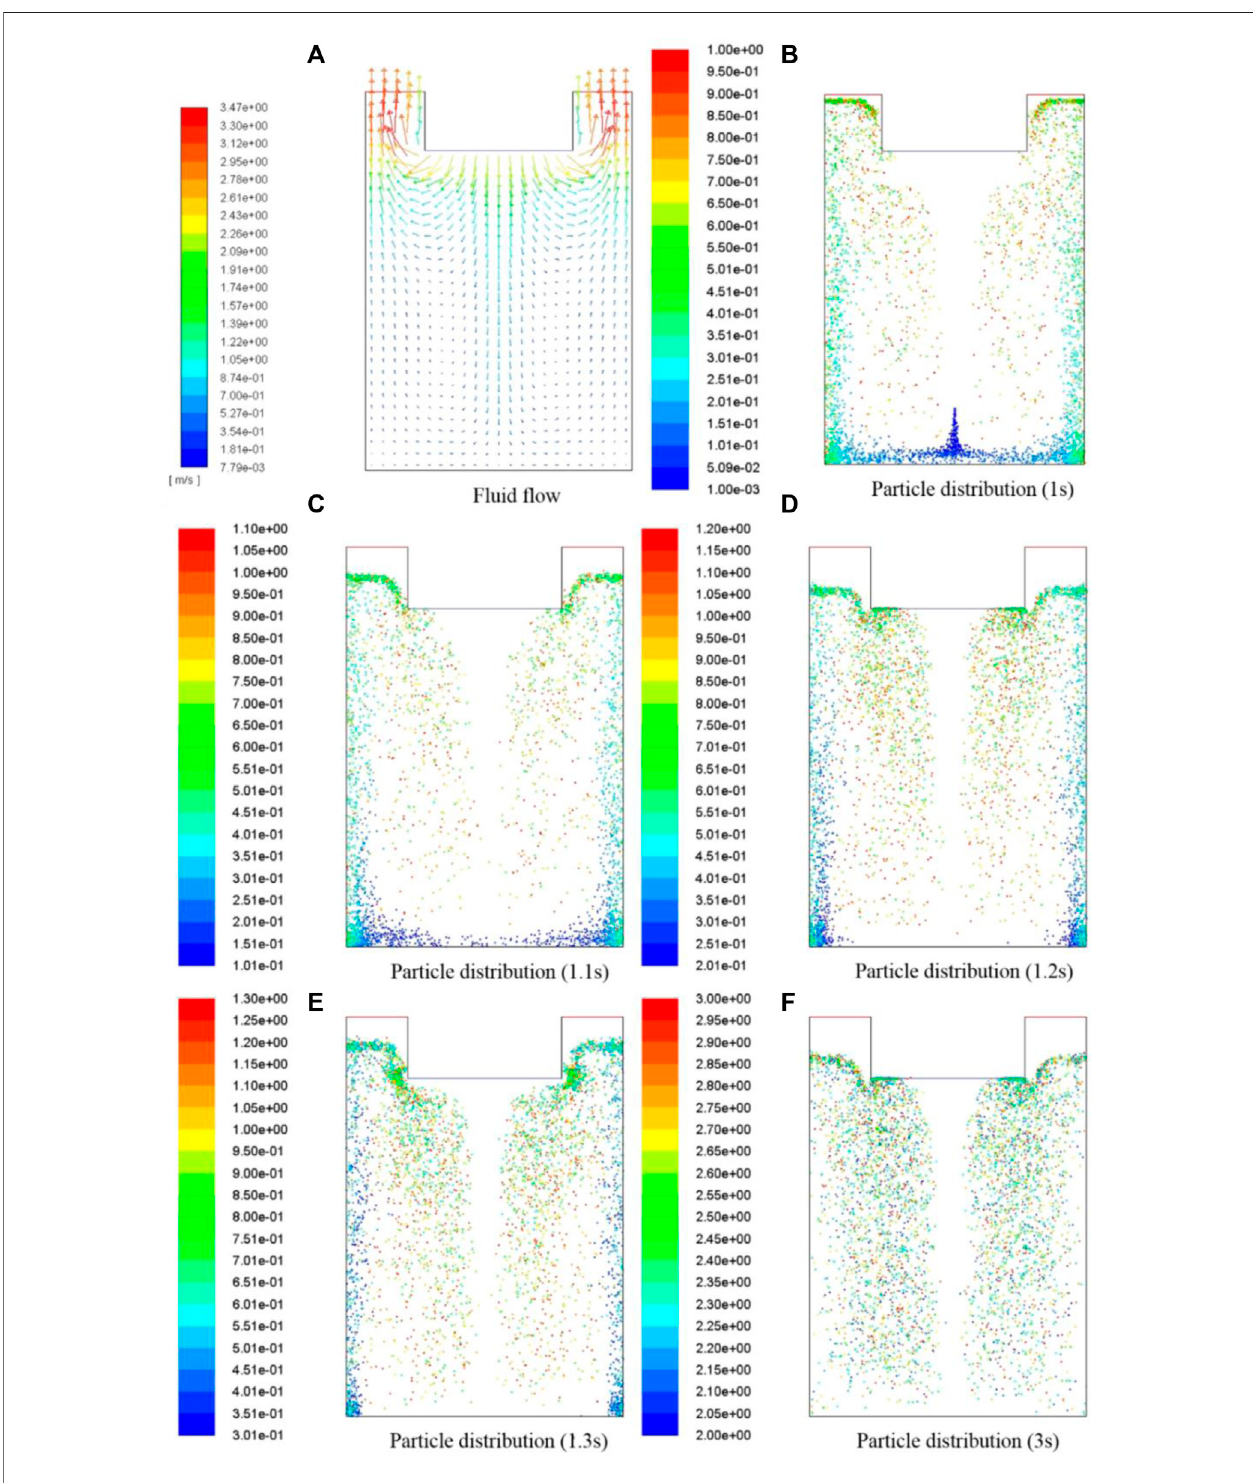
FIGURE 2 | Fluid fl ow (A) and effect of ultrasonic vibration time on nanoparticle distribution: (B) 1 s, (C) 1.1 s, (D) 1.2 s, (E) 1.3 s, and (F) 3 s.